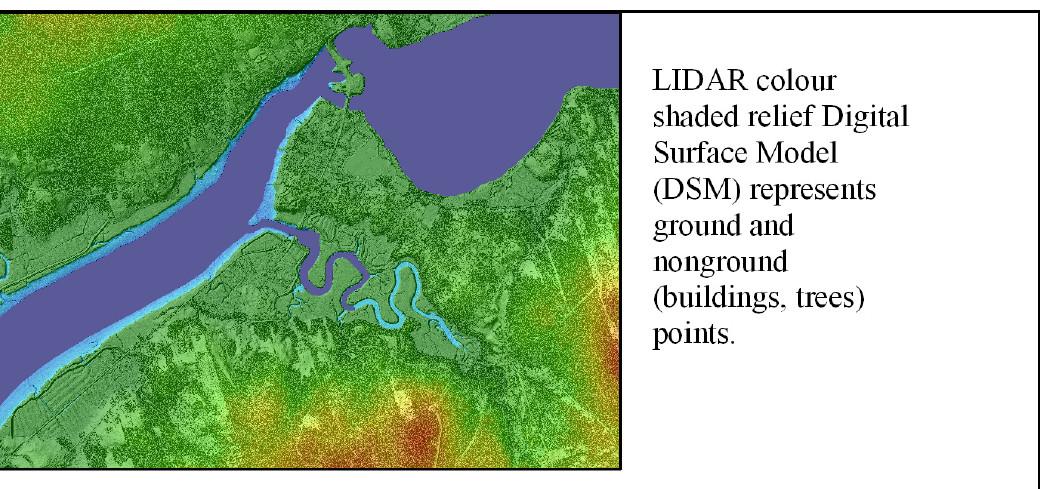
Figure 3. LiDAR surface models. Top: DSM; Middle: DEM; Bottom: seamless DEM comprised of LiDAR for the land and intertidal zone and bathymetric soundings from a chart. Blue shades are below mean sea level and elevation increases from green to red in